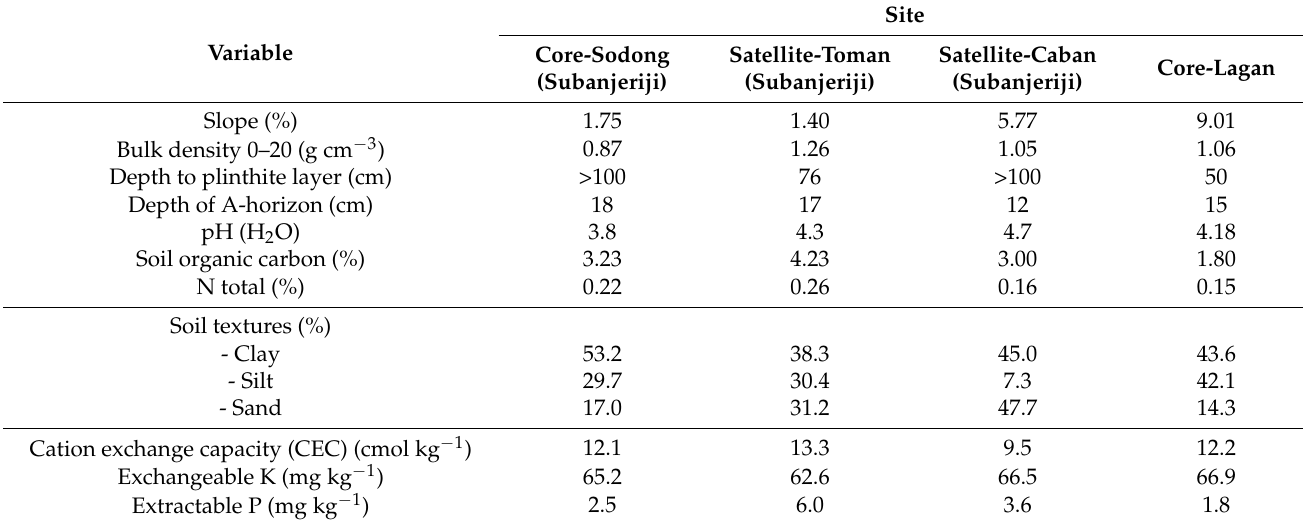
Table 1. Soil properties (0–20 cm depth) at mid-rotation experimental